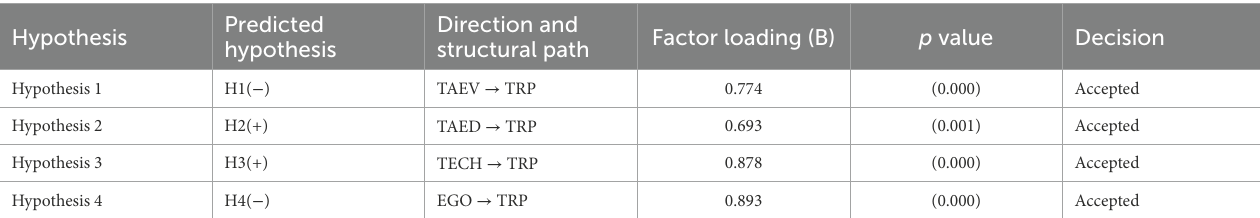
TABLE 6 Hypothesis testing results and